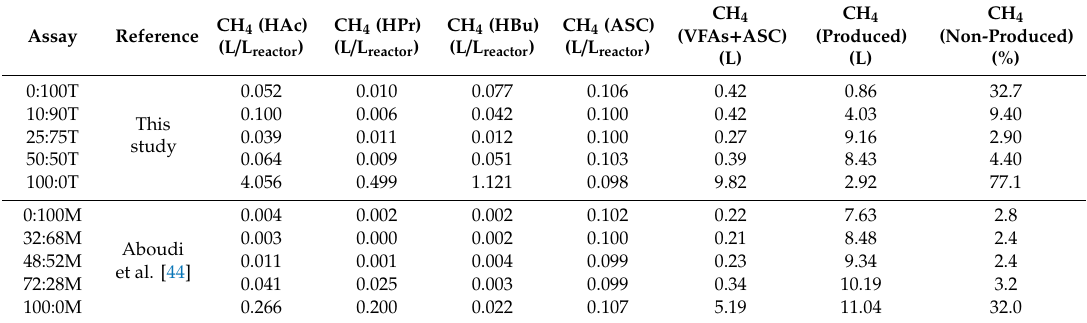
Table 2. Estimation of the theoretical methane from the non-converted Volatile Fatty Acids (VFAs) and Acidogenic Substrate as Carbon